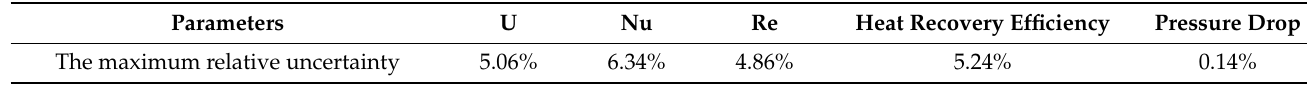
Table 3. The maximum relative uncertainties of the calculated parameters.